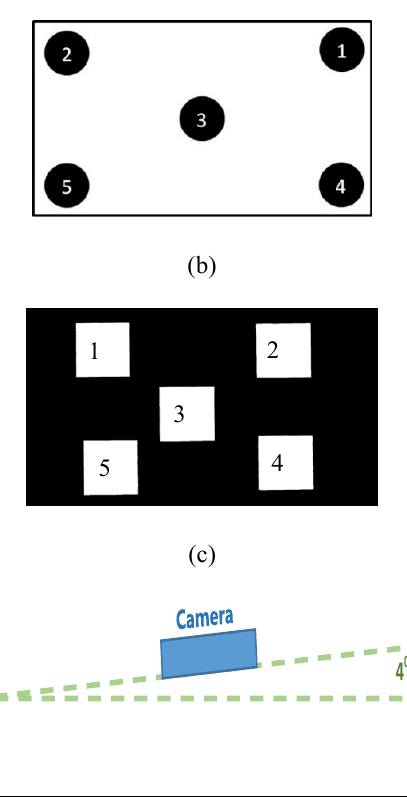
Figure 7. (a) Standard circle samples; (b) Standard rectangular samples; (c) Camera inclines to the base line with an angle of 4